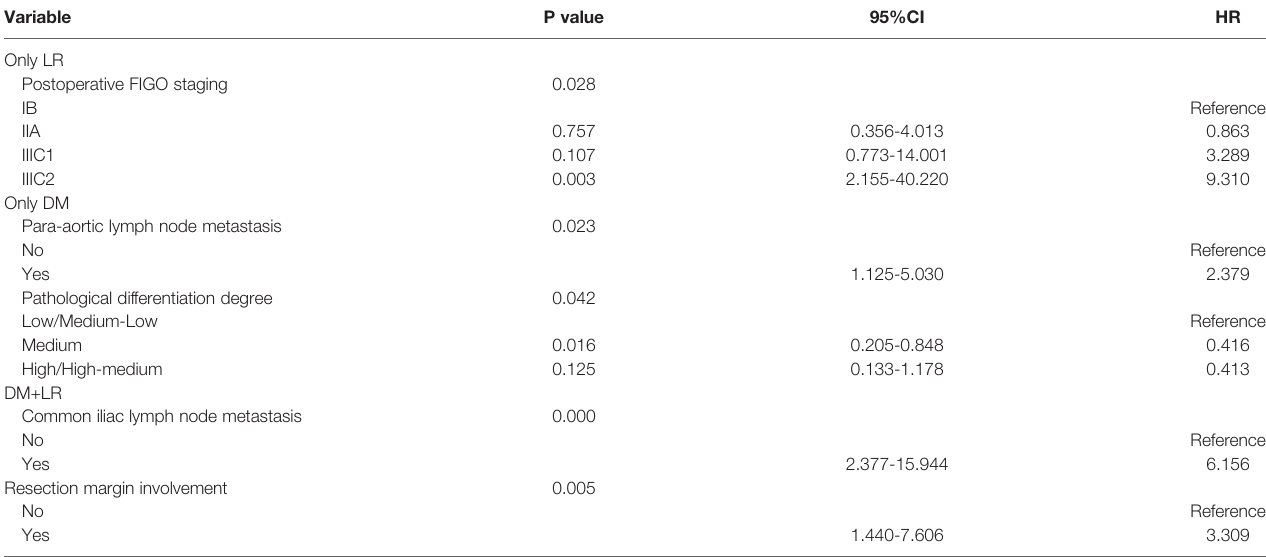
TABLE 3 | The prognostic factors of LR, DM, DM+LR. Variable P value Only LR Postoperative FIGO staging